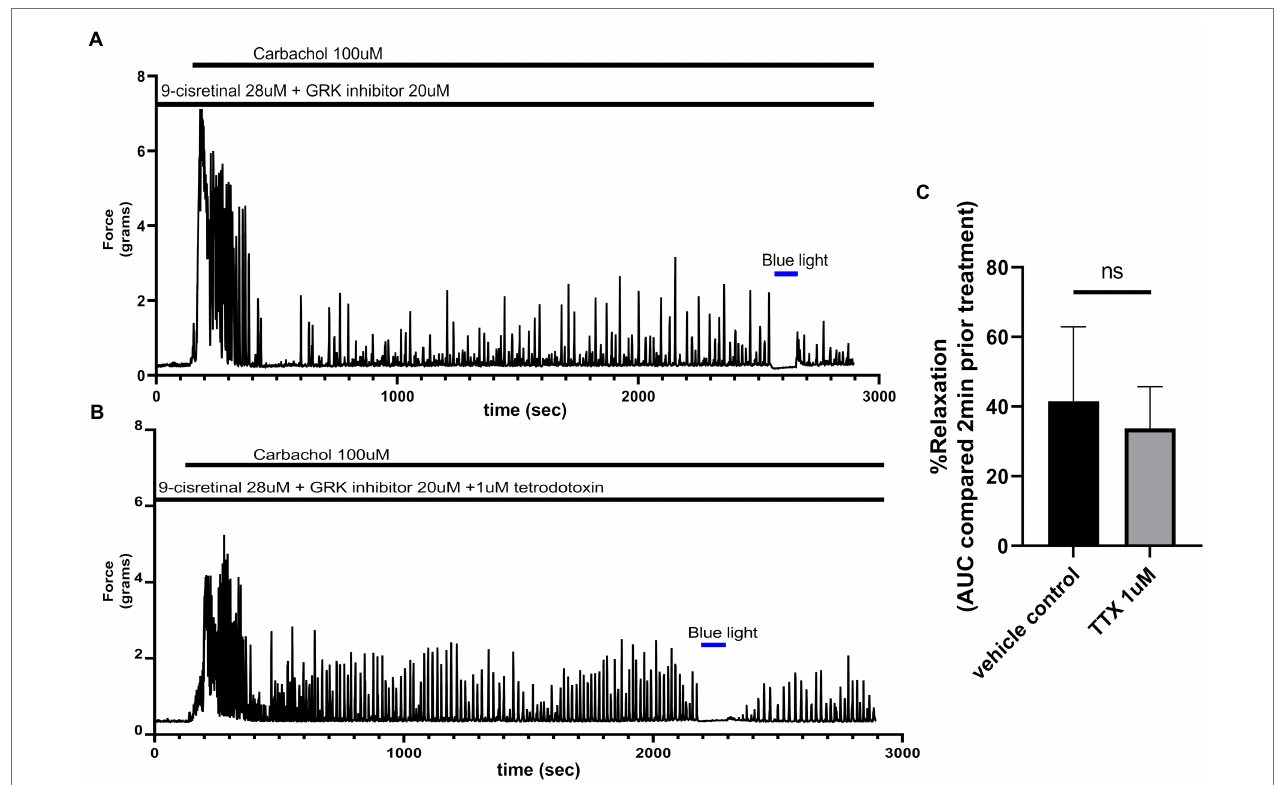
FIGURE 5 | (A) Representative force tracing of colonic rings pretreated with 9- cis retinal 28 μ M + GRK2 inhibitor 20 μ M and constricted with 100 μ M carbachol. Pretreatments depicted by the black bars. Blue bar depicts a 2 min 435 nm blue light treatment. (B) Representative force tracing of colonic rings pretreated with 9- cis retinal 28 μ M + GRK2 inhibitor 20 μ M + 1 μ M tetrodotoxin and constricted with 10 μ M of carbachol. Pretreatments are depicted by the black bars, and the blue bar depicts a 2 min 435 nm blue light treatment. (C) Area under the curve analysis of blue light-induced photorelaxation of rings precontracted with or without 1 μ M TTX. There was no significant difference between the means of TTX and vehicle treatment (42 vs. 34%, respectively), n =